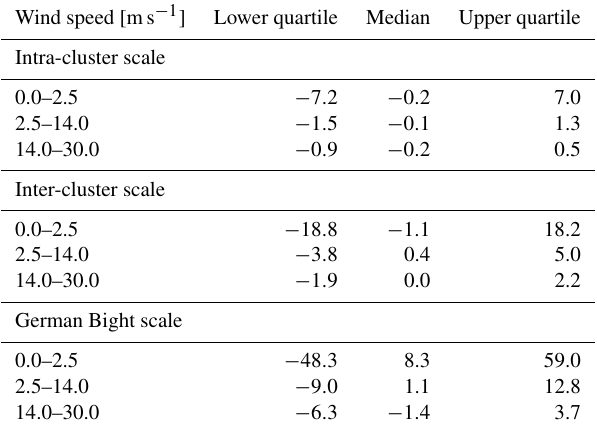
Table 1. Wind direction changes (in ◦ ) for the different operational ranges and spatial scales from the NEWA